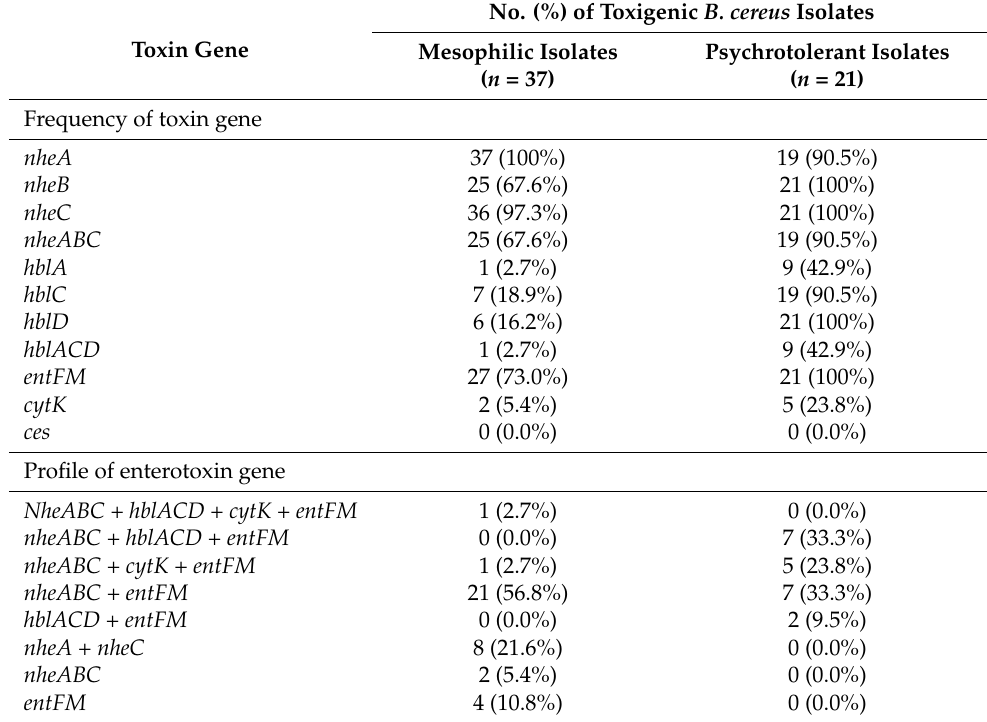
Table 4. Frequency and profile of toxigenic mesophilic and psychrotolerant B. cereus isolates from chilled